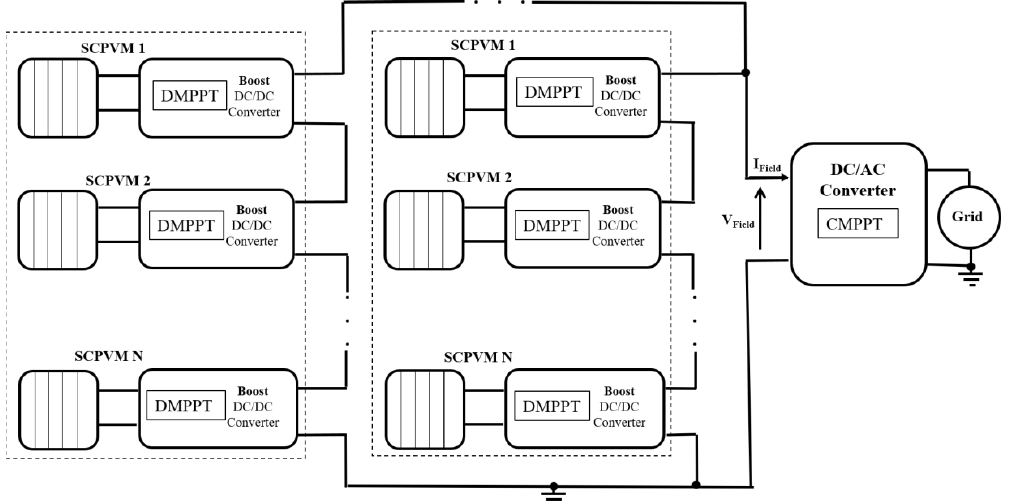
Figure 2. Distributed maximum power point tracking (DMPPT) architecture in grid-connected PV applications.